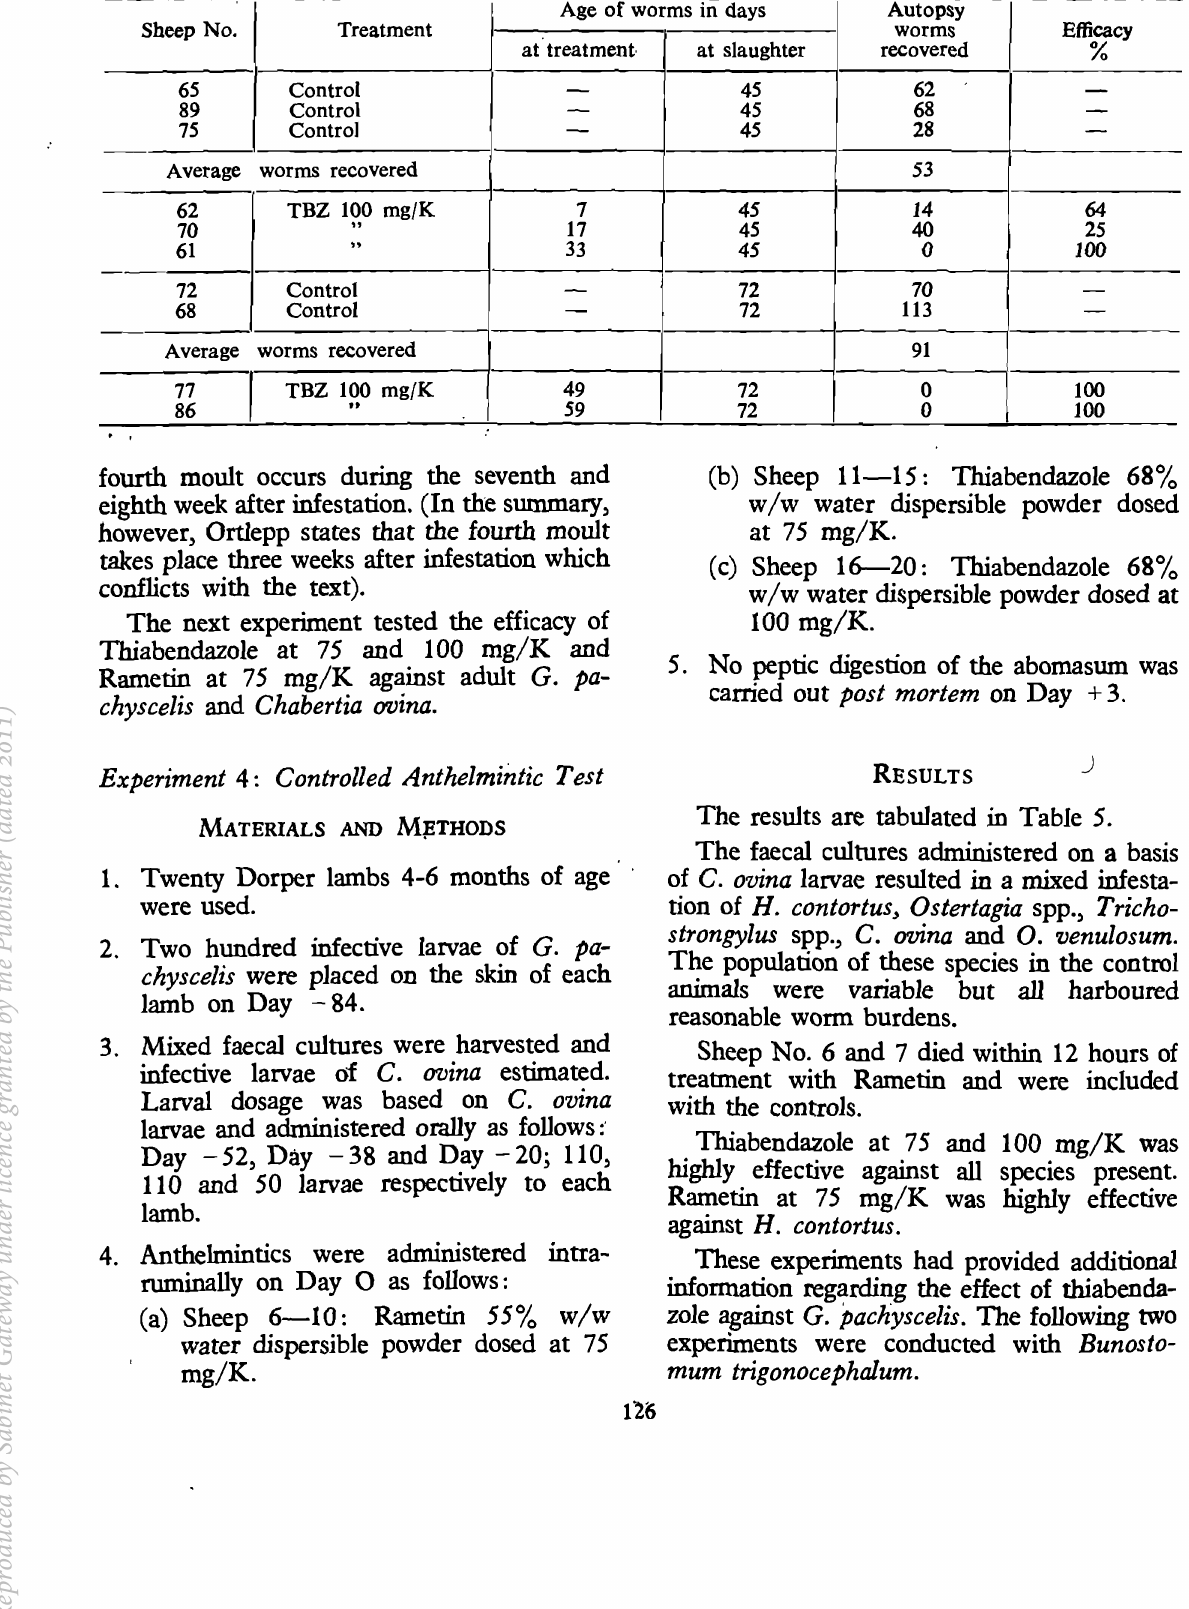
TABLE 4.-REsuLTS OF EXPERIMENT 3: CONTROLLI!D ANTHELMINTlCTEST AOAIN!rr G. pachyscelis Age of worms in days